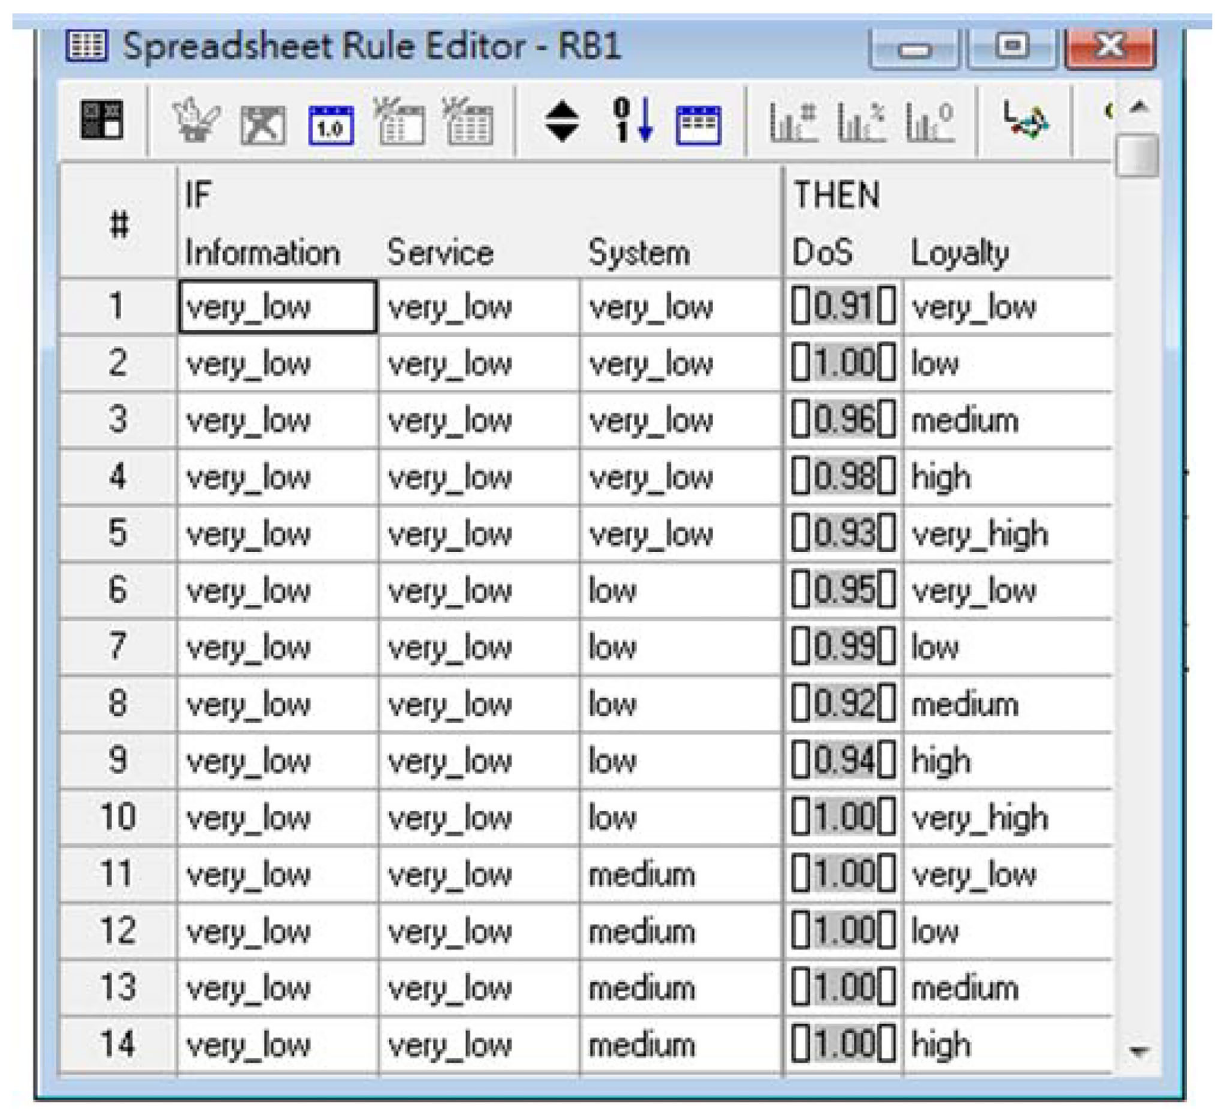
FIGURE 4 | Partial decision rules for measuring the possibility of